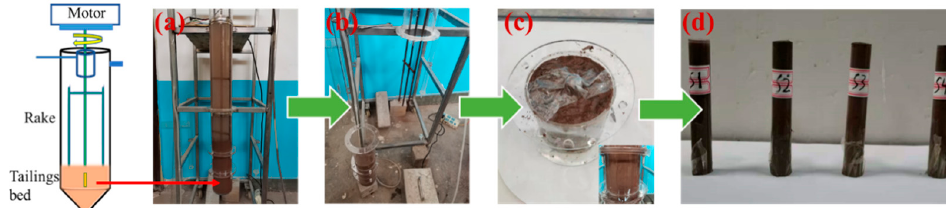
Figure 4. Sampling process: ( a ) Flocculation and sedimentation process; ( b ) Disassembly of settlement column; ( c ) Select target bed; ( d ) Conduct sampling.